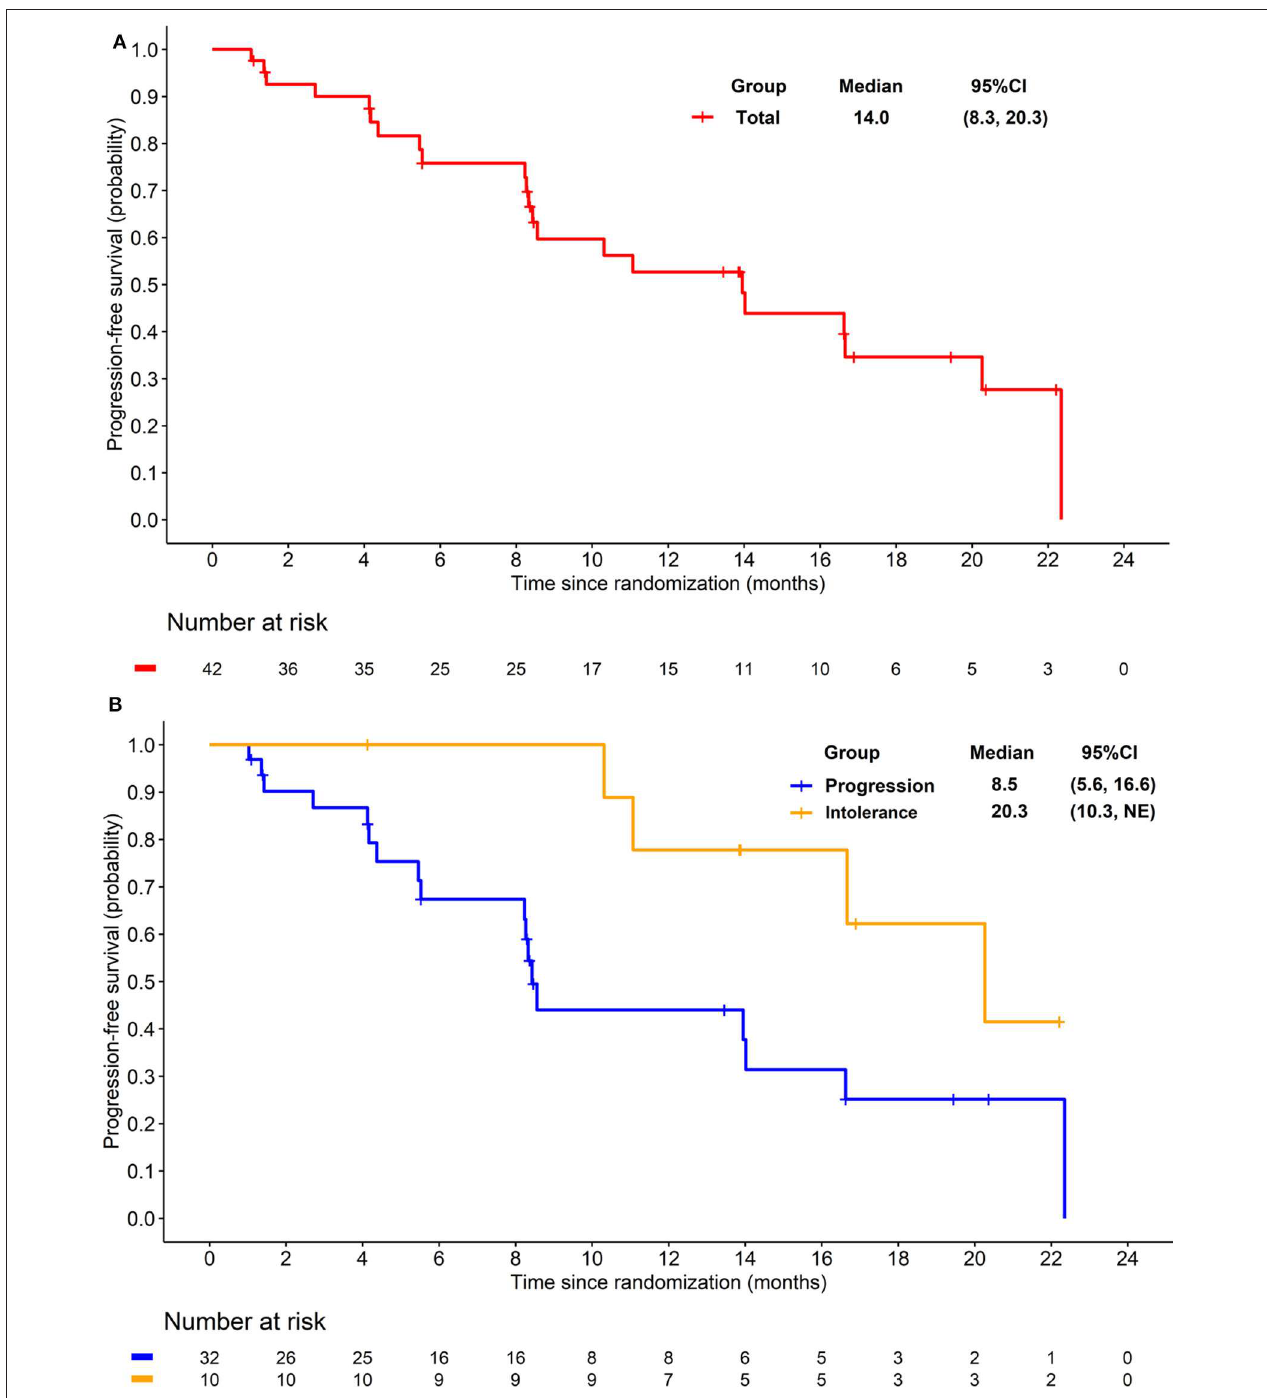
FIGURE 2 | (A) Kaplan-Meier plot of progression free survival in overall patients. (B) Kaplan-Meier plot of progression free survival in patients progressed from previous TKI treatment (Blue) and intolerant to previous TKI treatment (yellow).